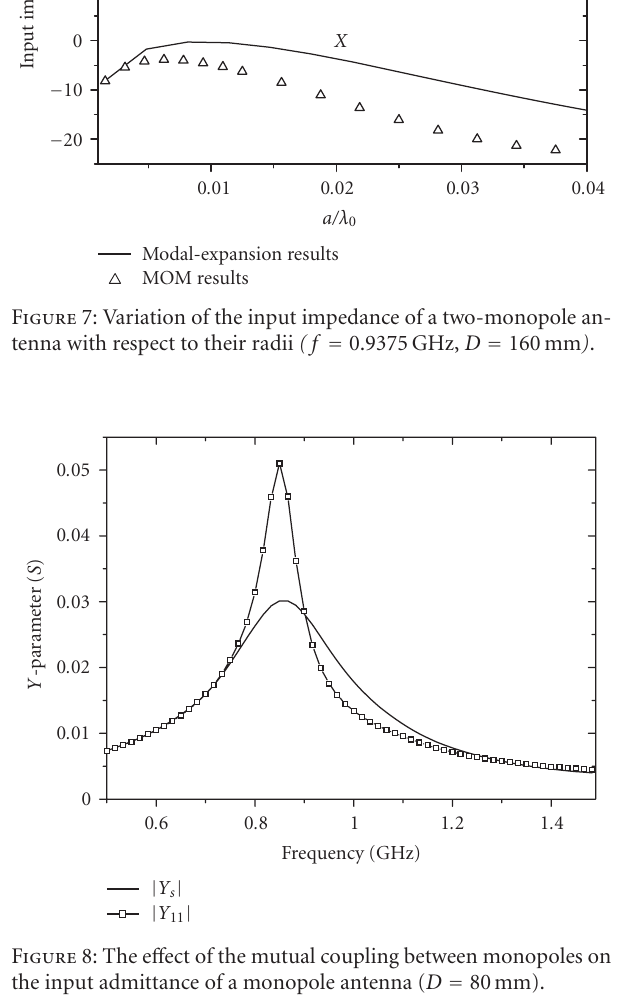
Figure 8: The e ff ect of the mutual coupling between monopoles on the input admittance of a monopole antenna ( D =